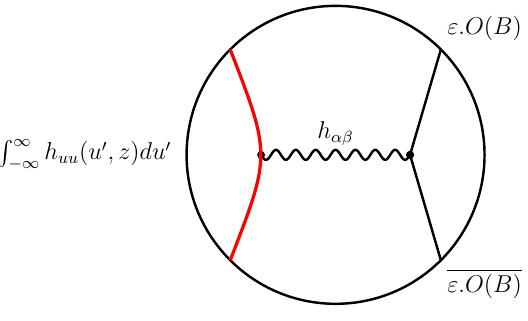
p (cid:26) ) ":O ( B ) i . " .O ( B ) du 0 h uu ( u 0 ,z = B p ⇢ ) " .O ( B ) . h i R